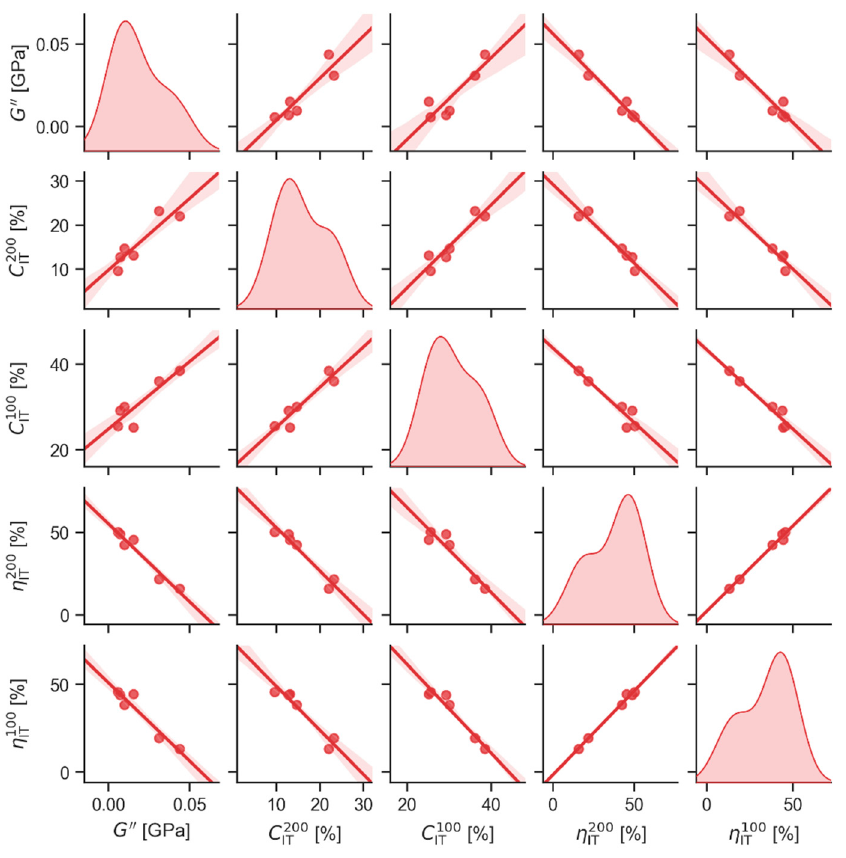
Figure 5. Scatterplot matrix graph showing the correlations between energy dissipation-related properties measured at the macroscale (loss modulus, measured in shear: G”) and microscale (indentation creep and the elastic part of indentation work: C IT and η IT , respectively). Both indentation creep and the elastic of the indentation work were measured at a higher loading force of 200 mN ( C 200 and η 200 ) and a lower loading force of 100 mN ( C 100 and η 100 ). The diagonal elements of the scatterplot matrix graph show the distributions of individual quantities, while off-diagonal elements show the correlations between each pair of quantities. The translucent bands around the linear regression lines represent 80% confidence interval of the regression estimate.